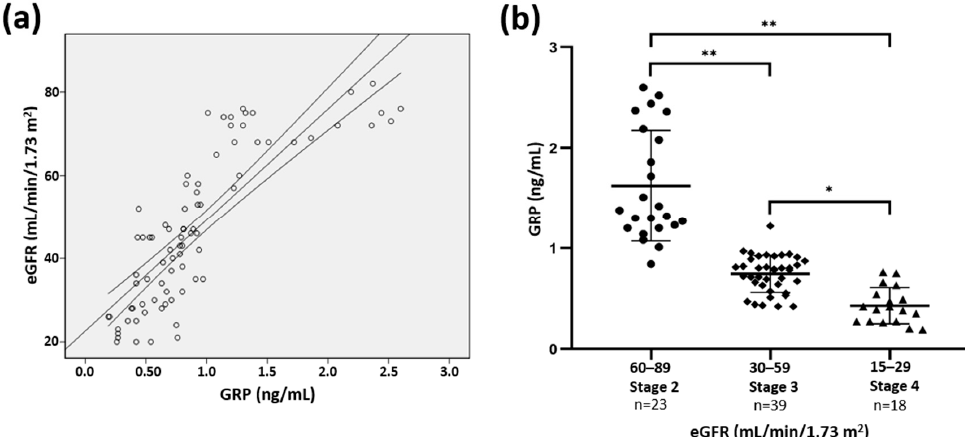
Figure 1. Association between serum Gla-rich protein (GRP) levels and kidney function. ( a ) The simple linear regression was used to assess the relationship between estimated glomerular filtration rate (eGFR) and serum GRP levels ( β = 0.821; p < 0.0001). ( b ) Serum GRP levels divided by chronic kidney disease (CKD) stage. ANOVA test and a post hoc analysis with Sche ff e test was used to analyse di ff erences among the 3 groups (* p = 0.001, ** p <